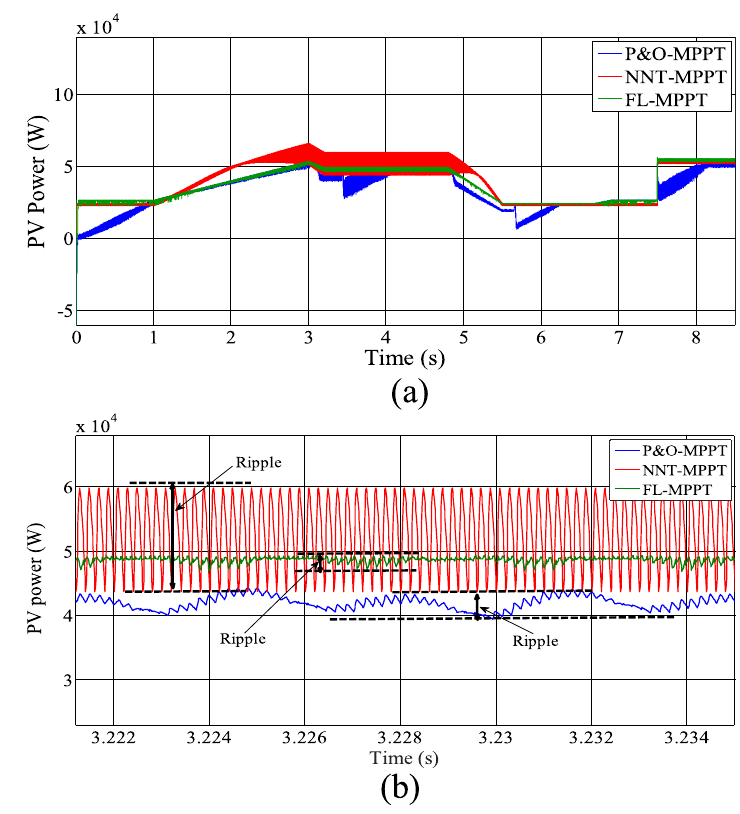
Fig. 15 a PV power. b PV power